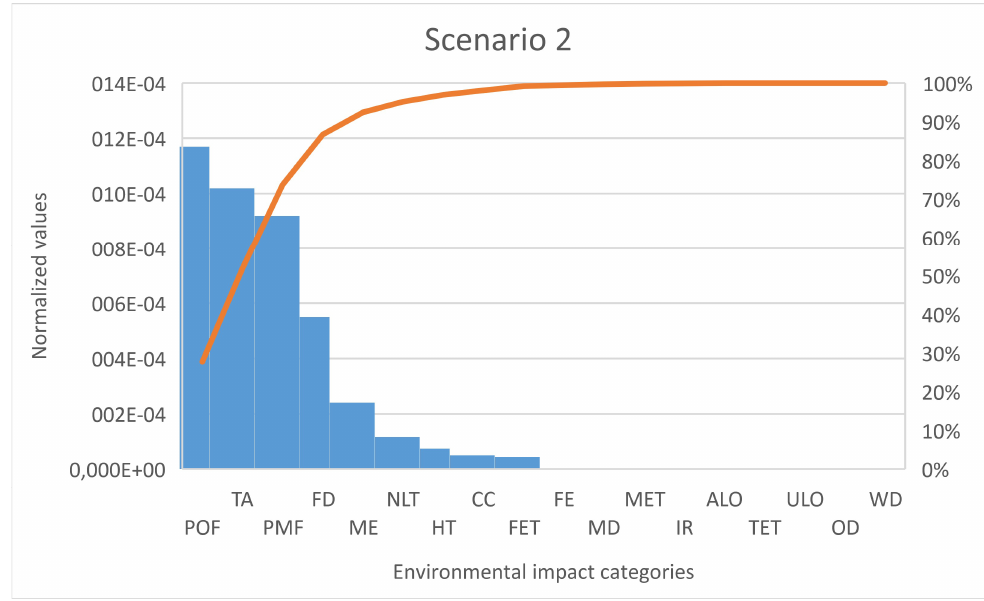
Figure 3. Pareto analysis for scenario 1 (only visible values).